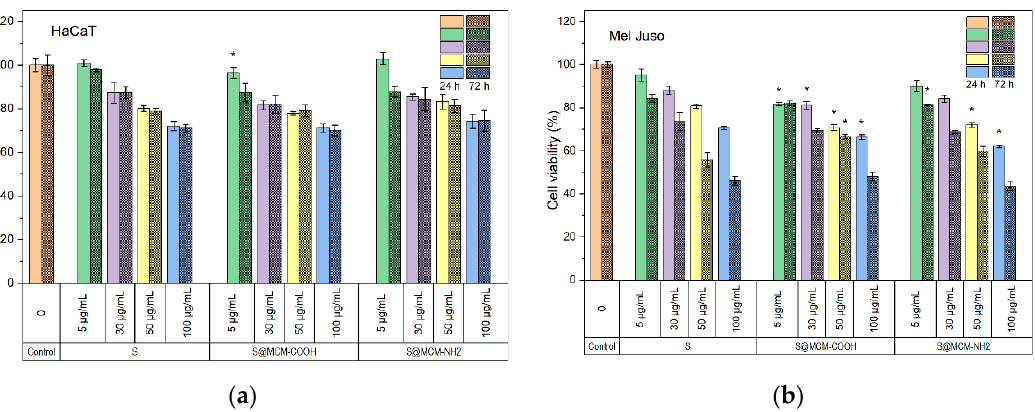
Figure 6. Cytocompatibility results of embedded and free extract on human keratinocyte normal cells ( a ) and antiproliferative activity on human melanoma cells ( b ). All results are expressed as mean values ± standard deviation (n = 3). * p < 0.05 compared to free extract, S (Student’s t -test).